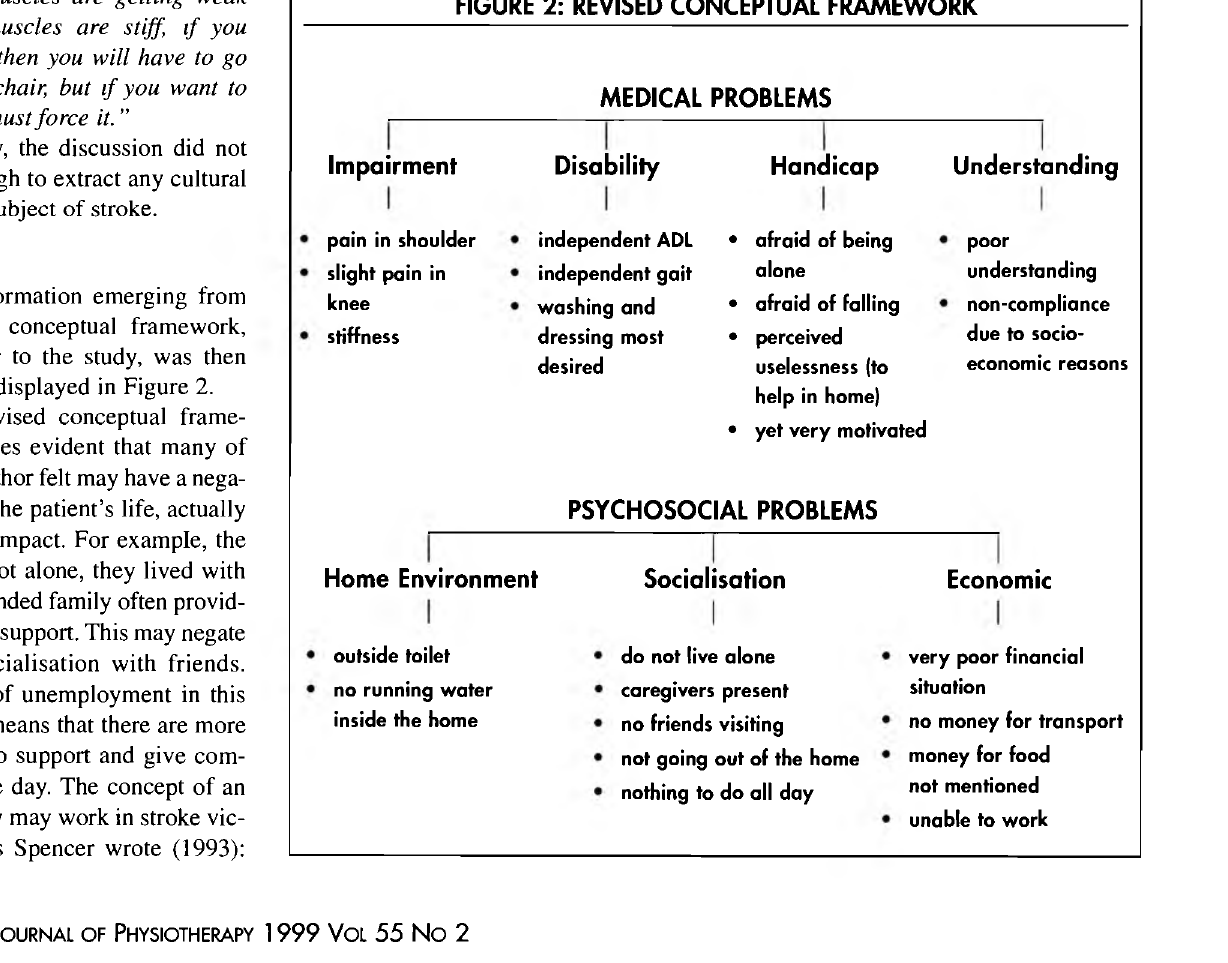
FIGURE 2: REVISED CONCEPTUAL